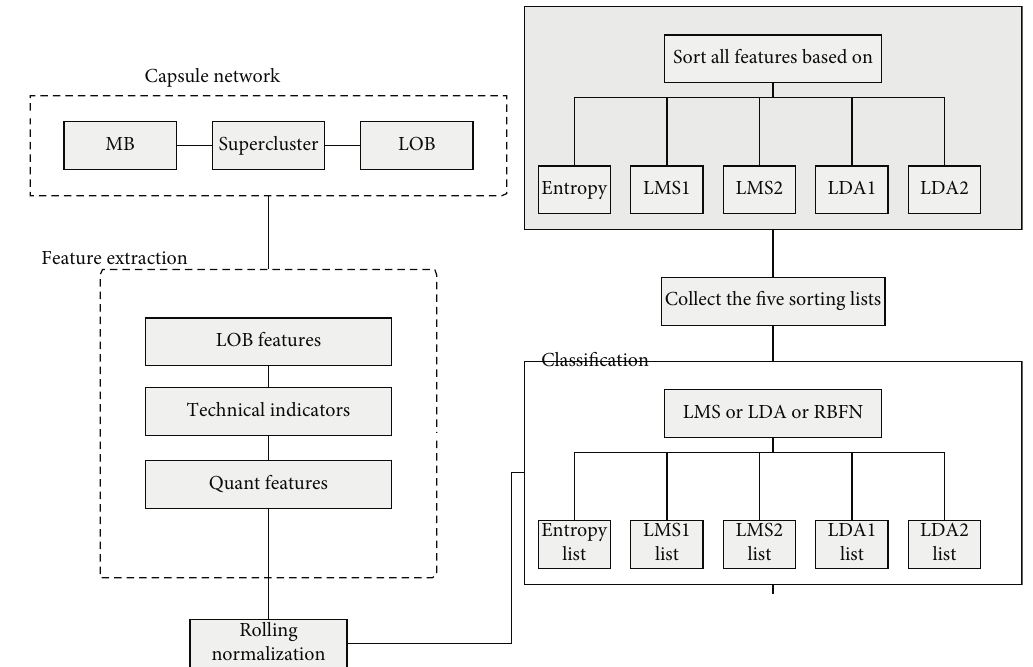
Figure 2: Capsule network data classification